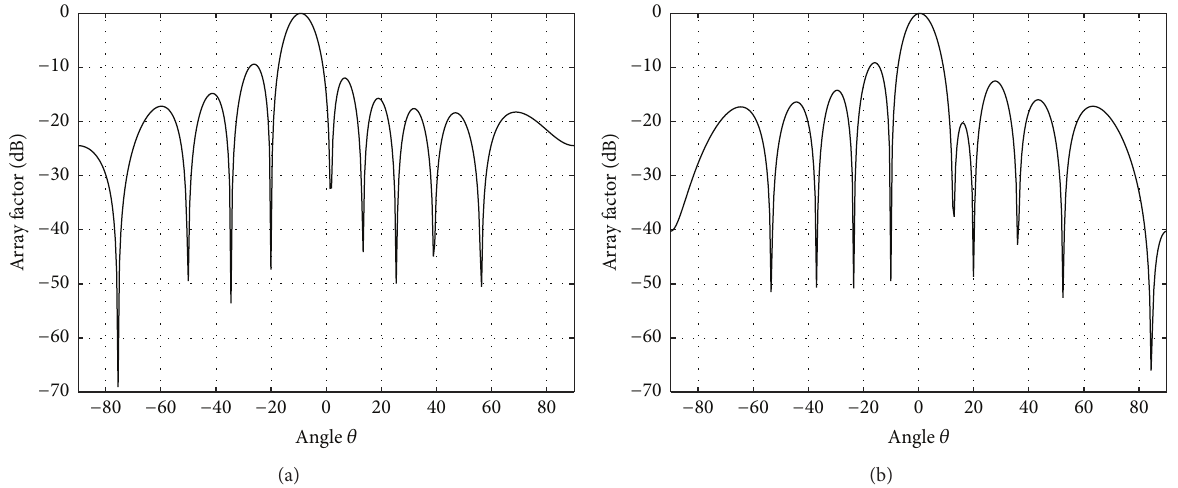
Figure 7: Normalized radiation pattern of the linear antenna array: (a) the angle of arrival of the desired signal is − 10 ∘ and the angle of arrival of the interfering signal is − 20 ∘ ; (b) the angle of arrival of the desired signal is 0 ∘ and the angles of arrival of the interfering signals are − 10 ∘ and 20 ∘ .